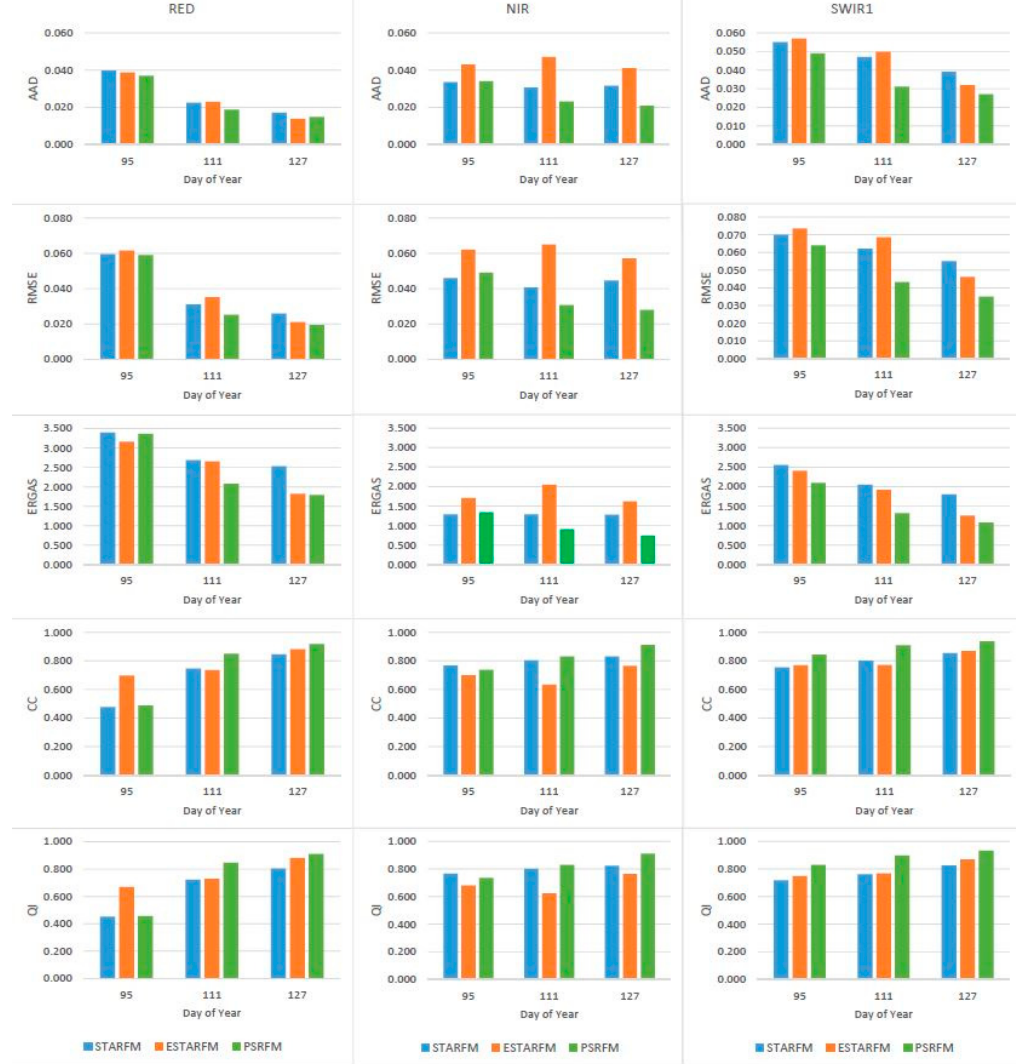
Figure 5. Quality indices comparison of the predicted Landsat-like image time series by the three models STARFM, ESTARFM and PSRFM. Three columns present the three bands RED, NIR and SWIR1, respectively. (The smaller of AAD, REMS and ERGAS, the better quality of the predicted image; and the bigger of CC and QI, the better quality of the image).